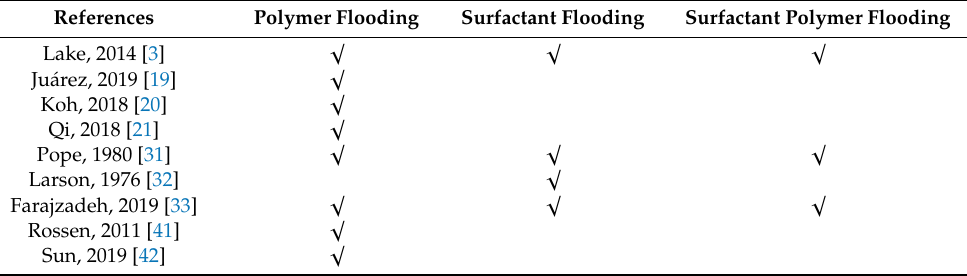
Table 1. Review of literatures about CEOR modeling using fractional